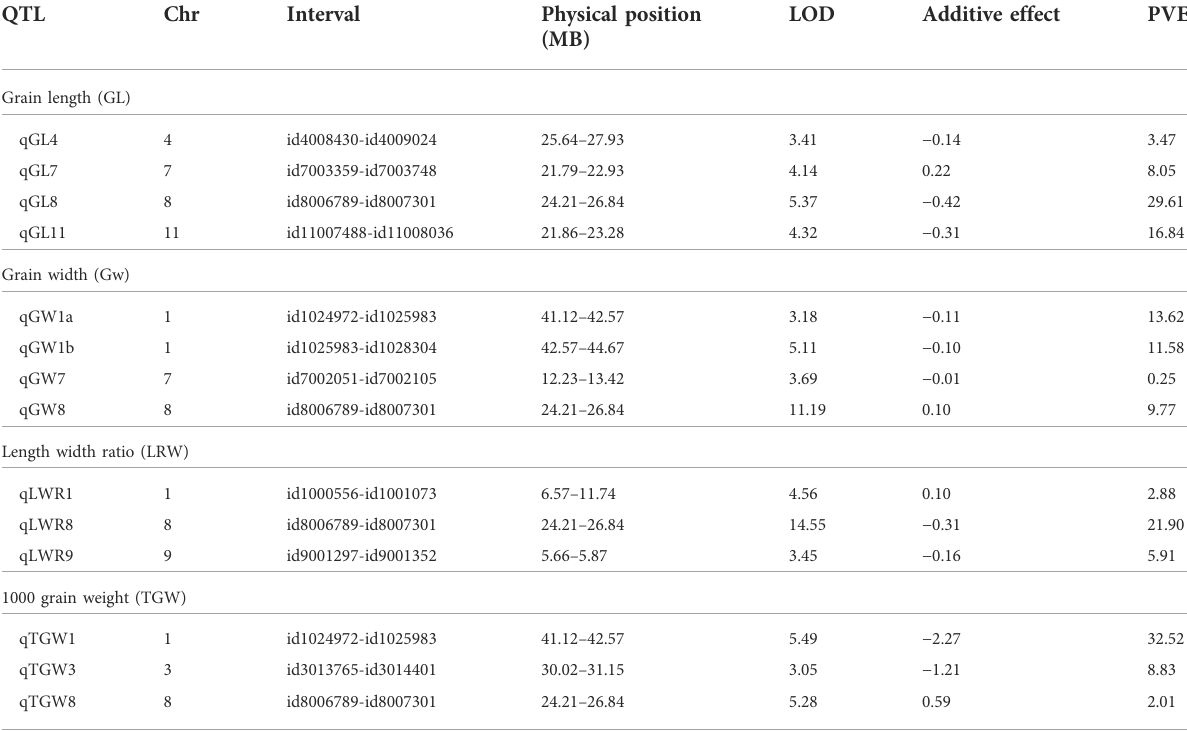
TABLE 3 QTLs for grain length, grain width, grain length – width ratio, and grain